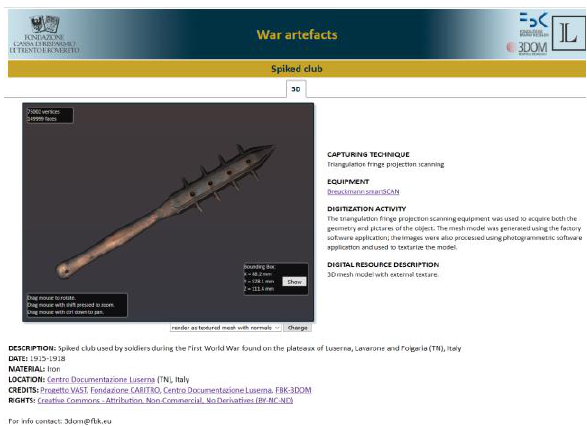
Figure 7. Example of web page displaying the 3D model of a war finding (http://3dom.fbk.eu/repository/files/vast/spiked_club/ spiked_club_3D.html).